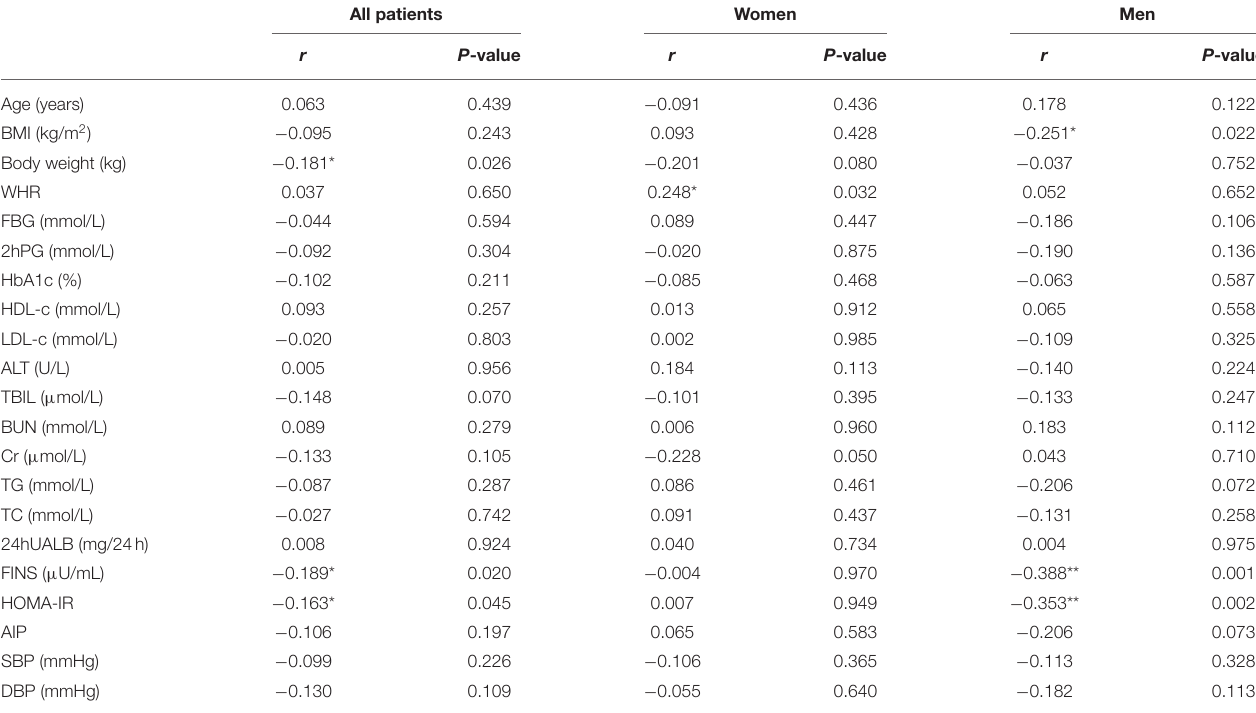
TABLE 2 | Spearman correlations between serum FGF19 levels and various physiological and clinical indicators. All patients Women